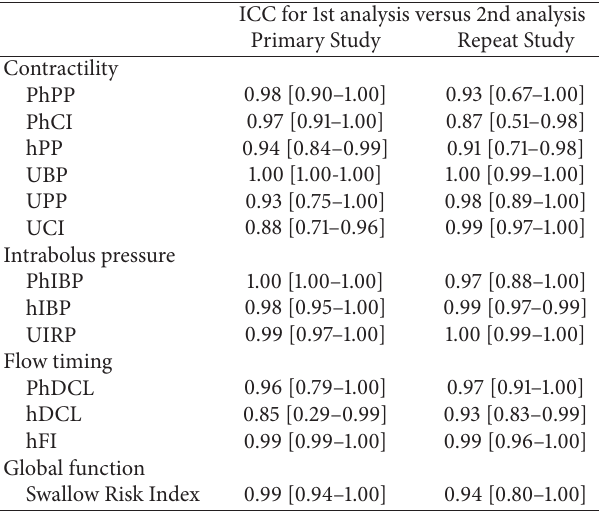
Table 3: Test-retest reliability of Primary Study versus Repeat Study for the 1st and 2nd analysis. Data are average ICC [range